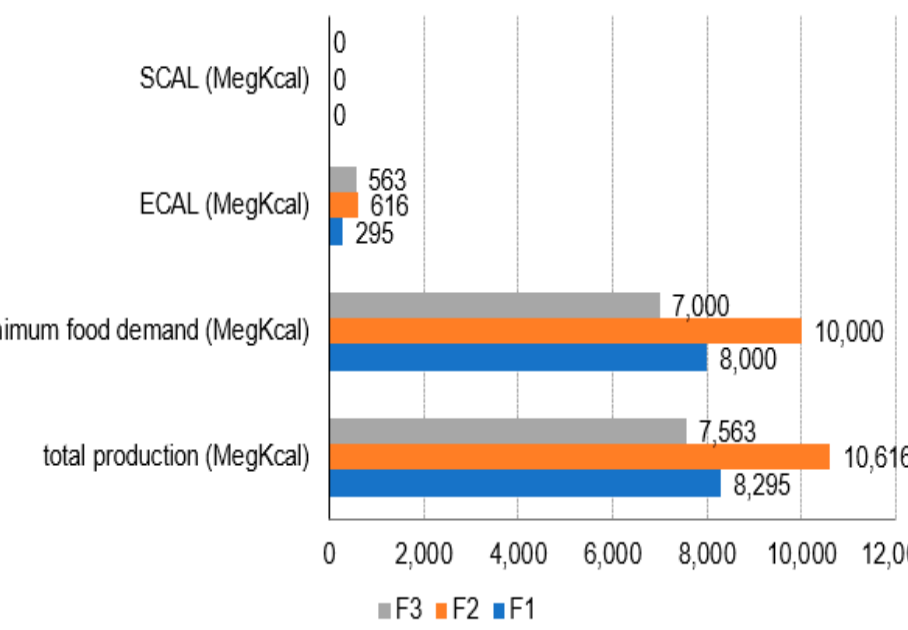
Figure 15. Food production produced from the three farms (MegKcal/farm/year).